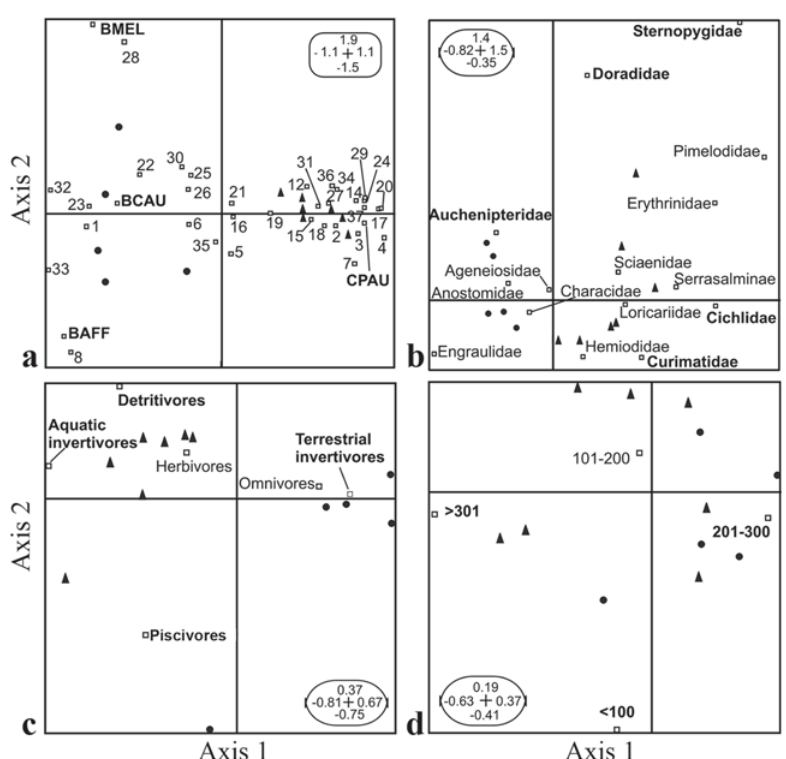
Fig. 3. Fish assemblage ordination resulting from a CA analysis using species (a), family (b), trophic guild (c), and MOS (d) descriptors in the upstream site, Comté River. Bold text indicates the species, family, trophic guild or MOS which contributes most to axes. Dots = samples taken during high waters; triangles = samples taken during low waters. Numbers correspond to fish species in Table 1. Axis scales are indicated in the small